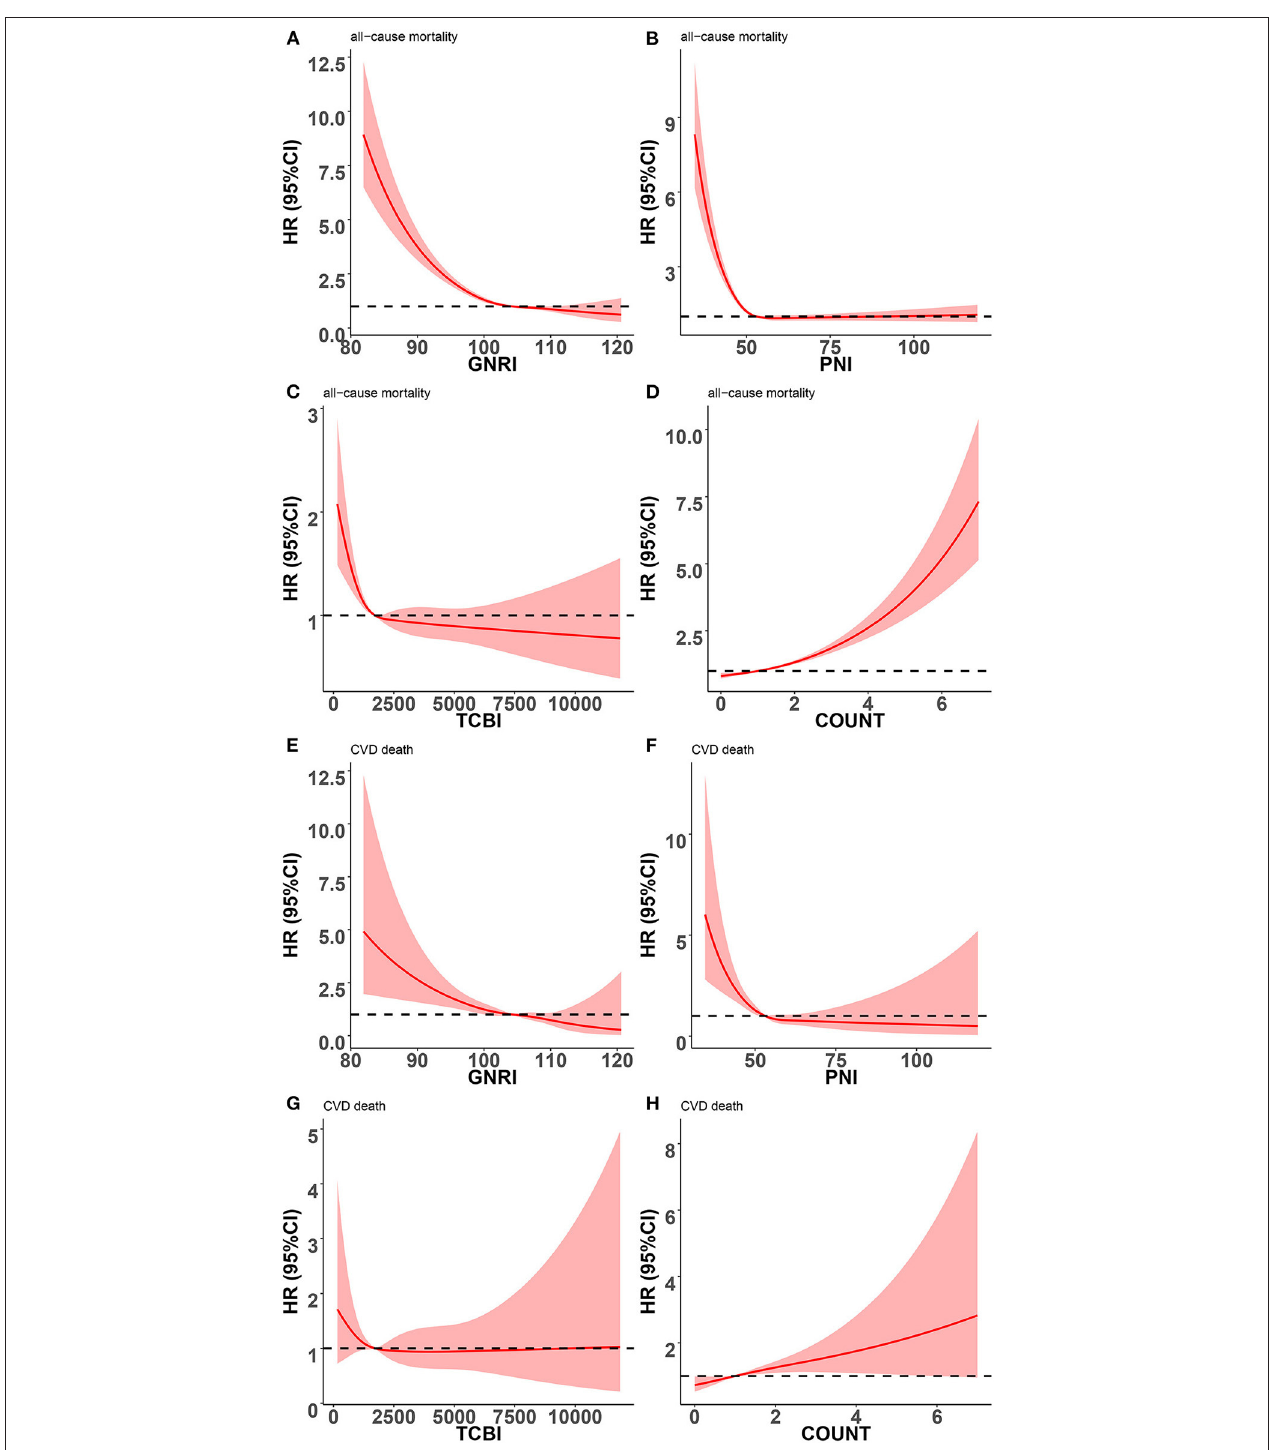
FIGURE 4 | Restricted spline curves for the associations between four nutritional scores and adverse events in general population. Red lines represent the HR (hazard ratio), and red transparent areas represent the 95% confidence intervals. HR (95% CI) were all adjusted according to Model 3 in Cox analysis. (A) Association between GNRI and all-cause mortality; (B) Association between PNI and all-cause mortality; (C) Association between TCBI and all-cause mortality; (D) Association between COUNT score and all-cause mortality; (E) Association between GNRI and cardiovascular death; (F) Association between PNI and cardiovascular death; (G) Association between TCBI and cardiovascular death; (H) Association between COUNT score and cardiovascular death; PNI, Prognostic Nutritional Index; GNRI, Geriatric Nutritional Risk Index; CONUT score, Controlling Nutritional Status score; TCBI, Triglycerides × Total Cholesterol × Body Weight Index.